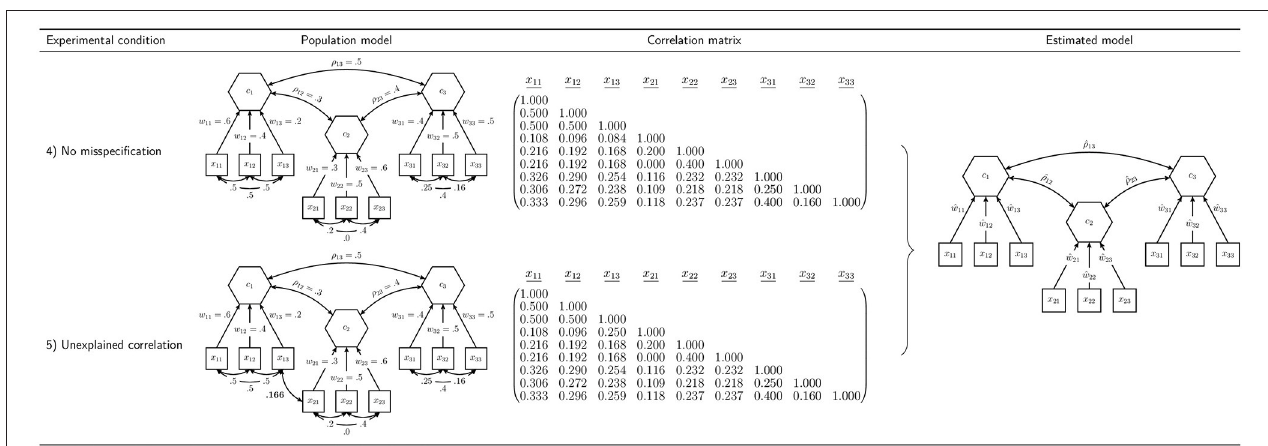
FIGURE 5 | Simulation design for the model containing three